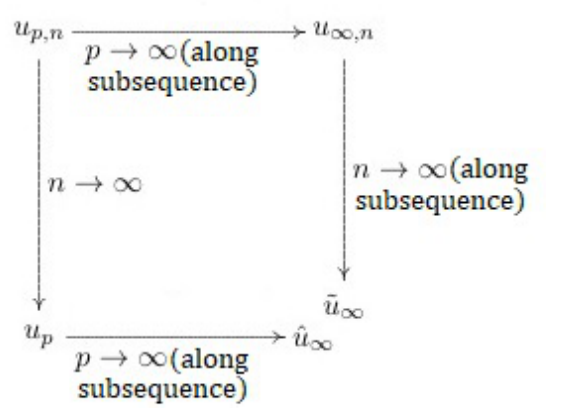
Figure 4. Summary of the convergence. The subscripts refer to p and the steps n of the pre-farctal approximating domains,